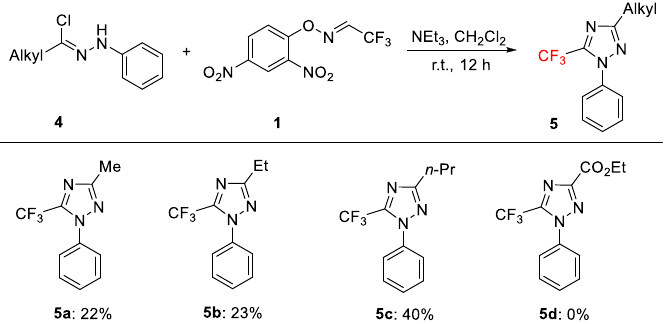
Figure 4. Scope of alkyl-substituted hydrazonyl chlorides. Reaction conditions: 4 (0.30 mmol), 1 (0.20 mmol), NEt 3 (0.60 mmol, 3.0 equiv), CH 2 Cl 2 (1.0 mL), r.t., 12 h, in benchtop air atmosphere. Isolated yields (calculated on basis of starting material 1 ). reacted with 1 to produce the corresponding product, 5e , in a 26% yield (Scheme 2).